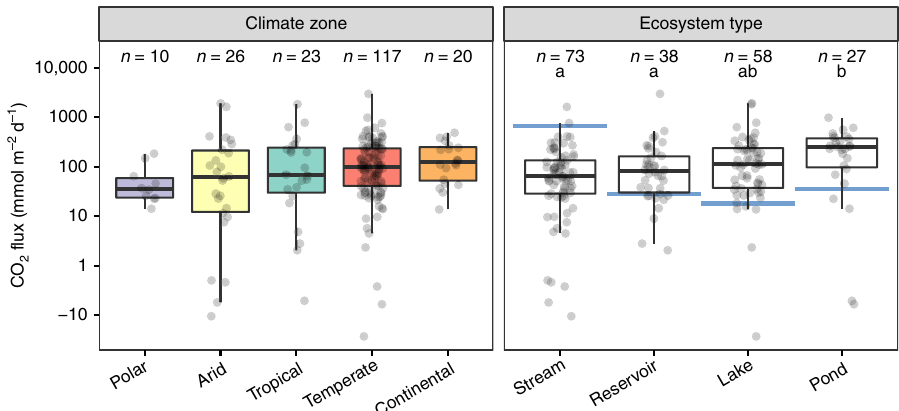
Fig. 2 CO 2 fl uxes separated by climate zones and ecosystem types. Box = 25th and 75th percentiles, whiskers = 1.5* inter-quartile range. Black line = median. Blue lines represent average estimates of CO 2 emissions for inland waters as reported in the literature 11, 20, 21 . Colours refer to climate zones as de fi ned in Fig. 1. Note that the y -axis is presented on a log 10 scale to show a wide range of fl ux values. Letters indicate signi fi cant differences between ecosystem types (Kruskal – Wallis test and Dunn ’ s post hoc test, P